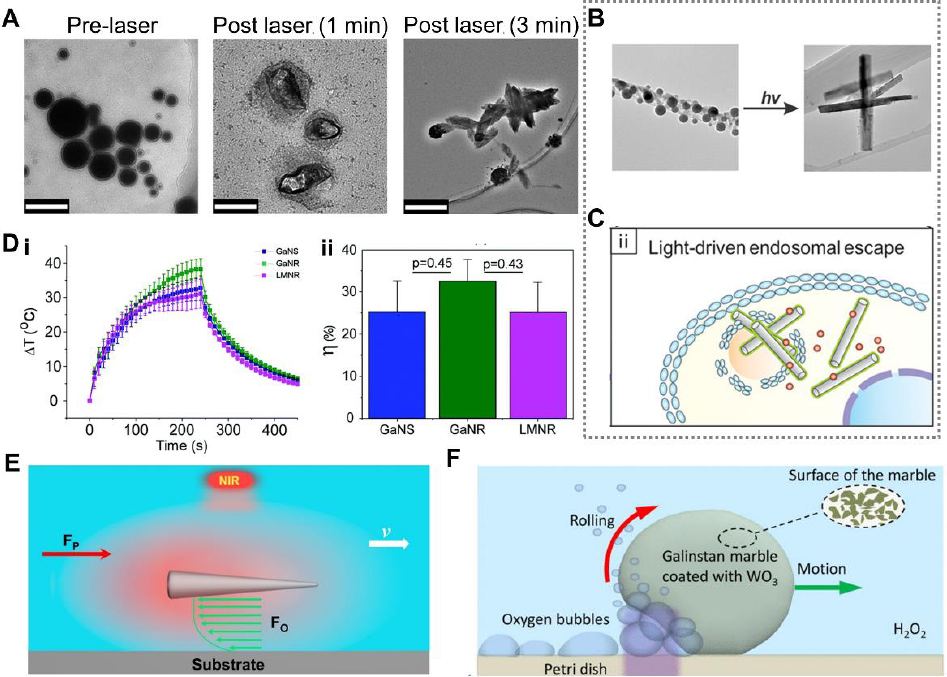
Figure 10. Optically Induced Response. ( A ) TEM images of liquid metal (LM) nanodroplets before and after laser irradiation. Scale bars are 200 nm, 100 nm and 500 nm, respectively. Reprinted from Ref. [145]. ( B ) TEM images of morphological transformation induced by light. Reprinted with per- mission from [32]. Copyright 2017, American Chemical Society. ( C ) LM nanodroplets physically disrupt endosomal membrane under light irradiation. Reprinted with permission from [32]. Copy- right 2017 American Chemical Society. ( D ) (i) Average temperature elevation of Ga nanospheres, Ga nanorods, and LM nanorods irradiated under a NIR laser. (ii) Photothermal conversion efficien-